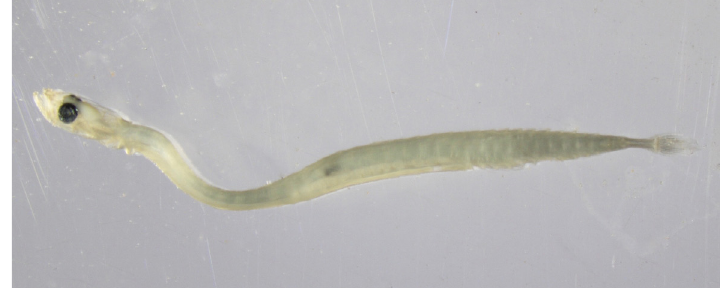
Fig. 1. Male Schindleria praematura (16.6 mm SL), collected from the Red Sea